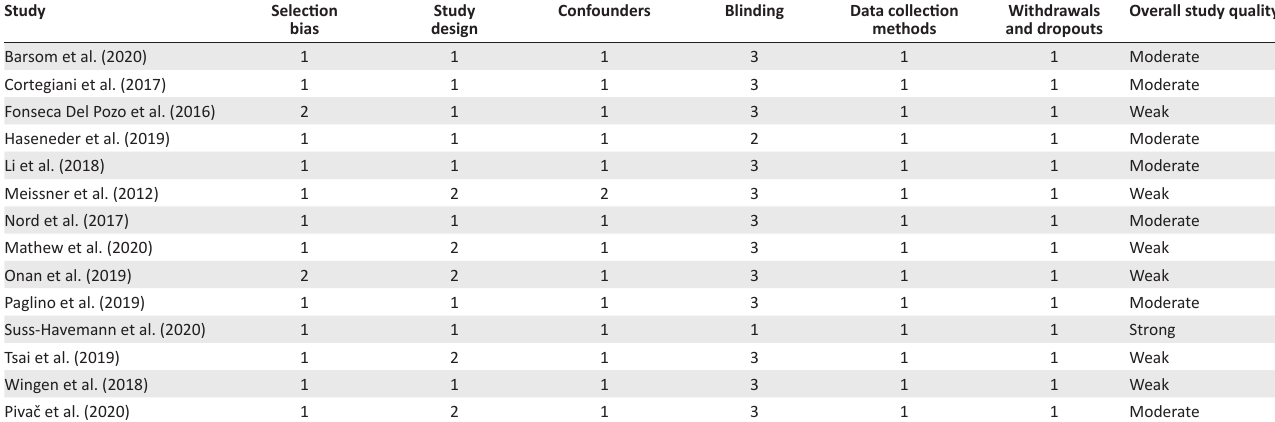
TABLE 1: Quality appraisal summary of the included studies.